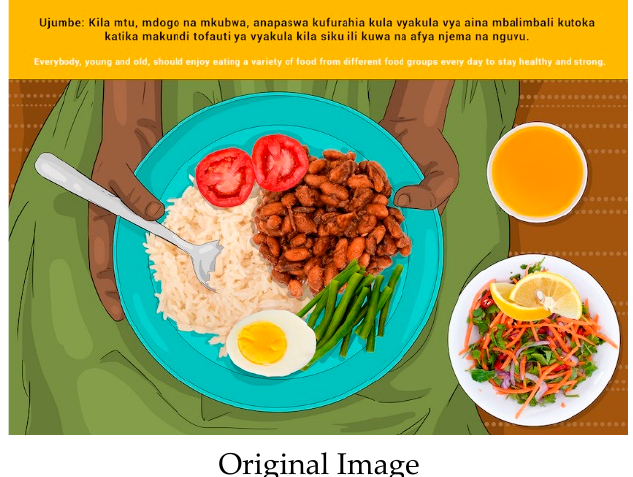
Figure 2. Everybody, young and old, should enjoy eating a variety of foods from different food groups every day to stay healthy and strong.